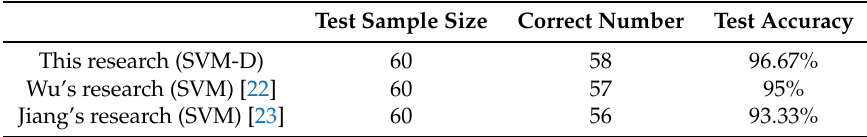
Table 7. Test results of different research works using